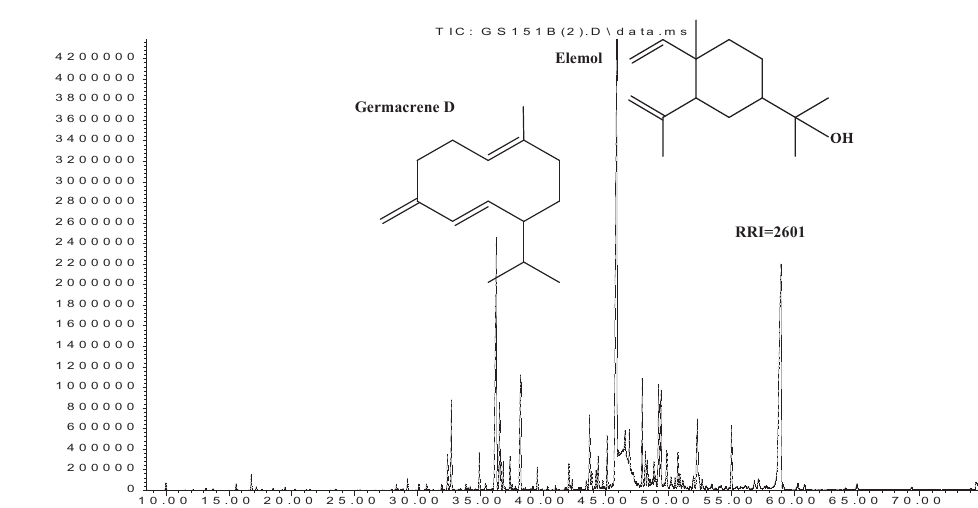
Figure 1. Figure 1: Chromatographic profile of P. heyniae EO on analytical polar HP Innowax